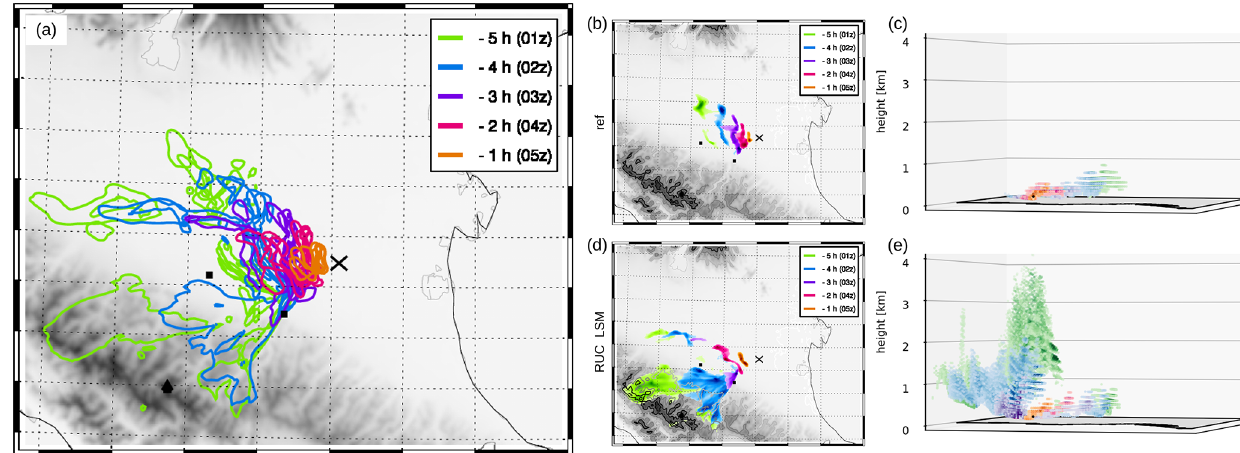
Figure 6. Horizontal (a, b, d) and vertical (c, e) distributions of source regions for 44 . 7 ◦ N, 11 . 6 ◦ E and 100ma.s.l. (black cross is target location) on 12 July 2012 at 06:00UTC. (a) Significant contributions to vertically integrated source regions for all model configurations, including increased roughness length, are given as isolines (colored by time according to legend). Gray colors indicate the surface topography. Panels (b) and (c) reference the configuration and (d) and (e) RUC LSM. For (b) and (d) , the viewing direction is from east-northeast towards